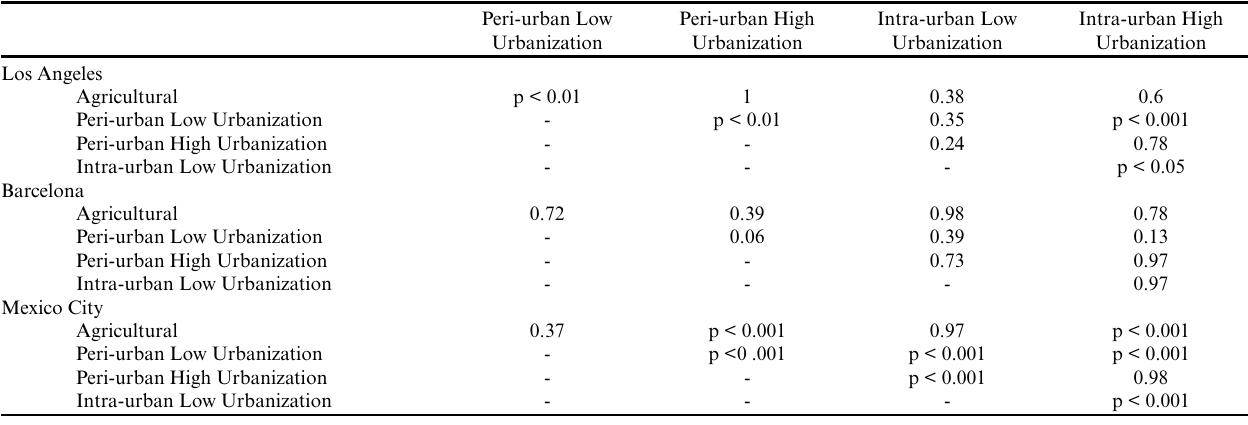
Table 4 . Pairwise Tukey comparisons for House Sparrow ( Passer domesticus ) abundances in the five land classes of the three studied urban-agricultural